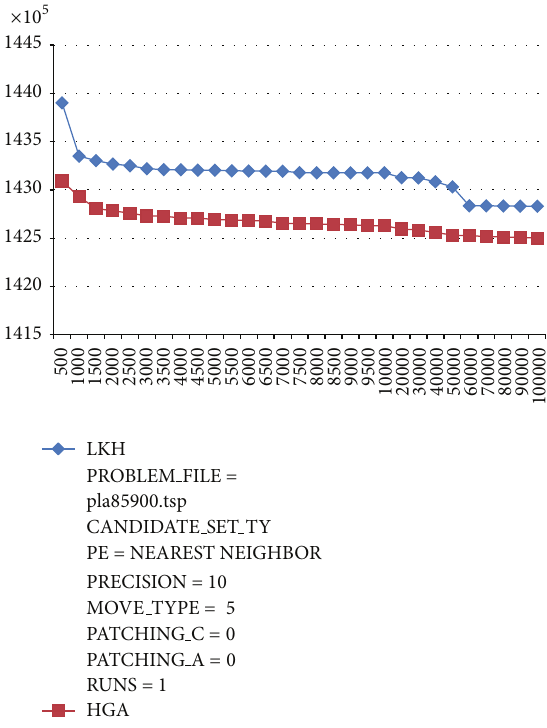
Figure 8: Competition between HGA and LKH during 100000